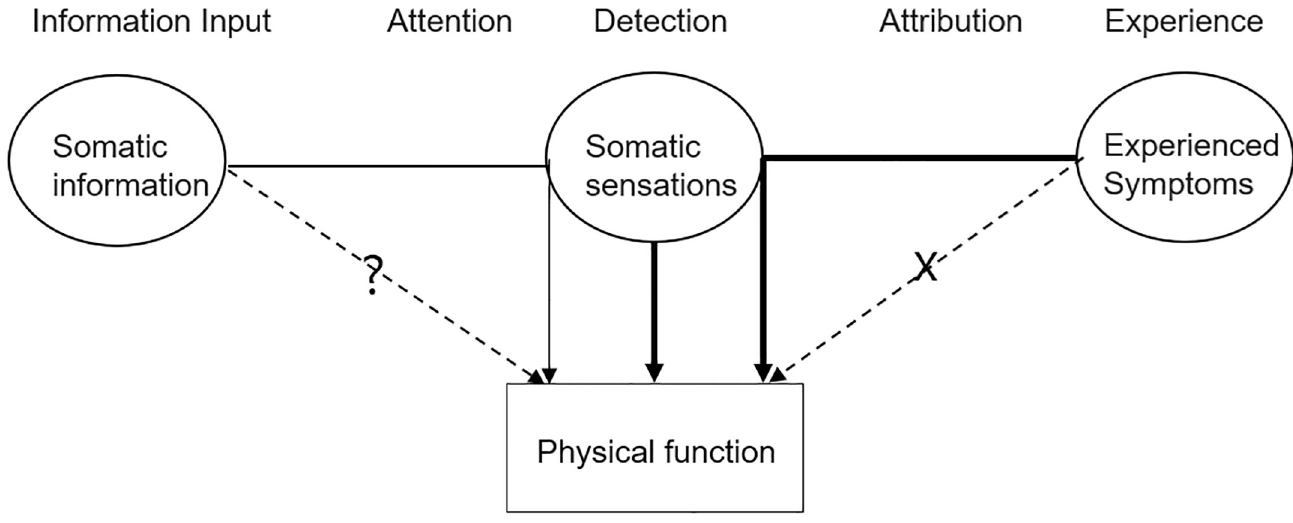
Fig 4. Simplified symptom perception-function